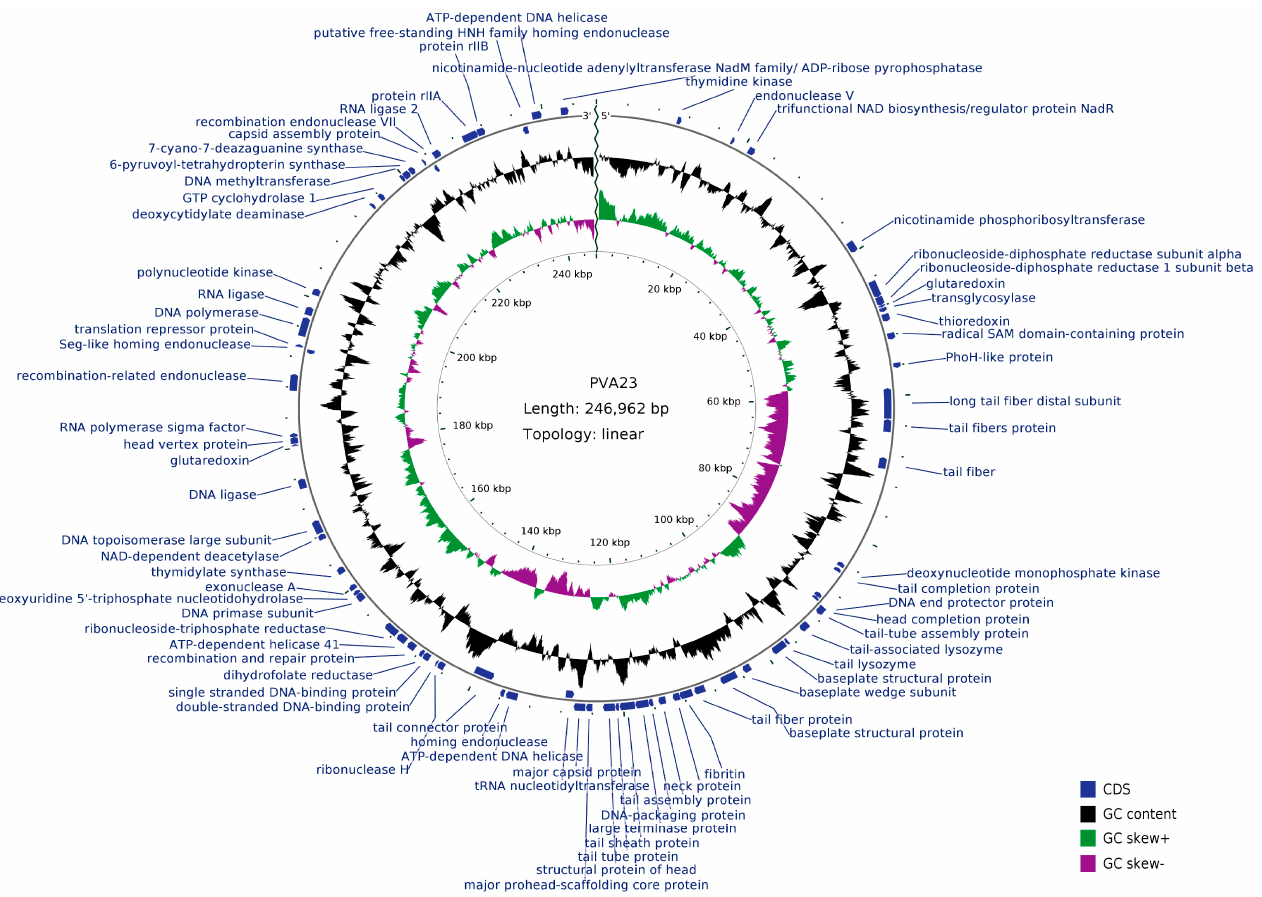
Figure 6. Genome circle map of PVA23. The outermost circle represents ORFs encoded in the genome. The two innermost circles represent GC-skew [(G – C)/(G + C)] and G + C content. The black circle represents the G + C content. The outward direction indicates that the G + C content of this region is larger than the average G + C content of the whole genome, and the inward direction indicates that the G + C content of that region is lower than the average G + C content. The gray circle represents the GC-skew [(G – C)/(G + C)]. The outward direction indicates that the GC-skew [(G – C)/(G + C)] is larger than zero, and the inward direction indicates that the GC-skew [(G – C)/(G + C)] is lower than zero.